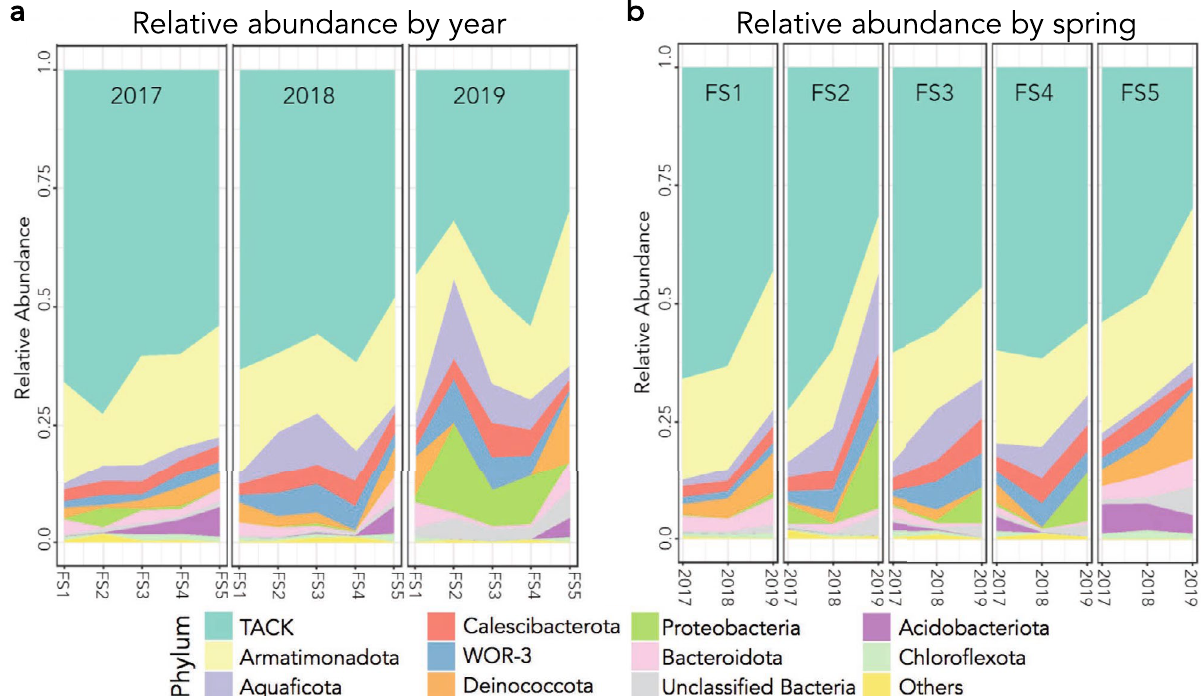
Figure 2. Relative microbial abundances were determined for each spring from 2017 to 2019. ( a ) Phylum-level relative abundance of each spring on a yearly basis. Microbial population composition changes over the three- year period. Each panel represents a year from 2017 to 2019 with springs FS1-FS5 relative abundance levels. ( b ) Phylum-level abundance across years for each of the Five Sisters springs.